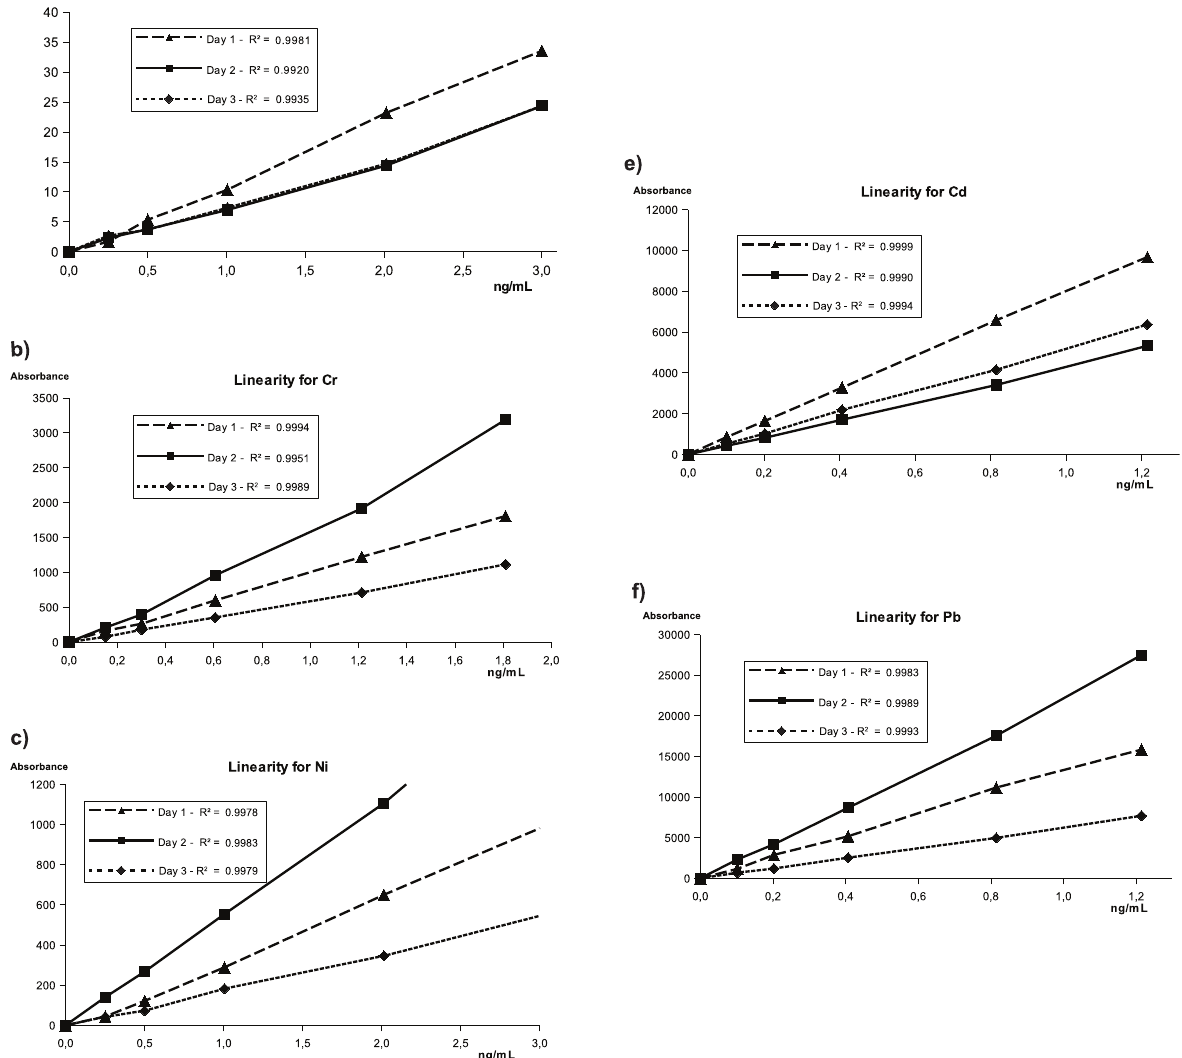
Figure 1 - Linearity data obtained from the readings of calibration curve which contained Standard solution of Se (A), Cr (B), Ni (C), Cd (D), Pb (E) in three consecutive